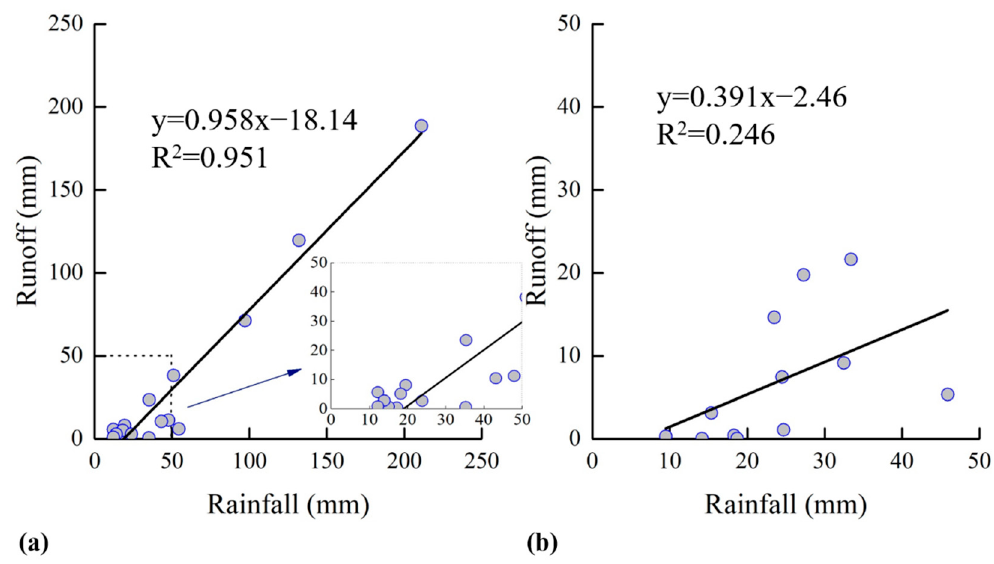
Figure 5. Linear corrections between rainfall–runoff depth of different events: ( a ) in the HQW site, ( b ) in the BTQ site.